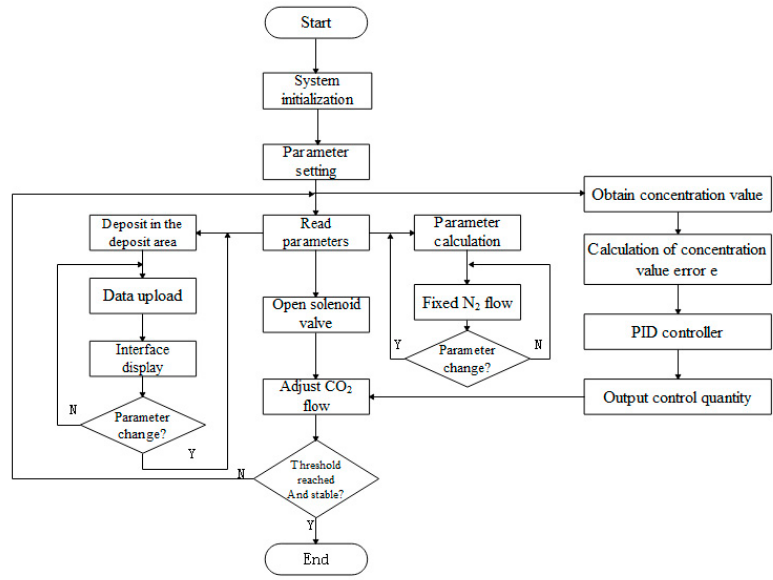
Figure 12. Flow chart of the gas distribution process.